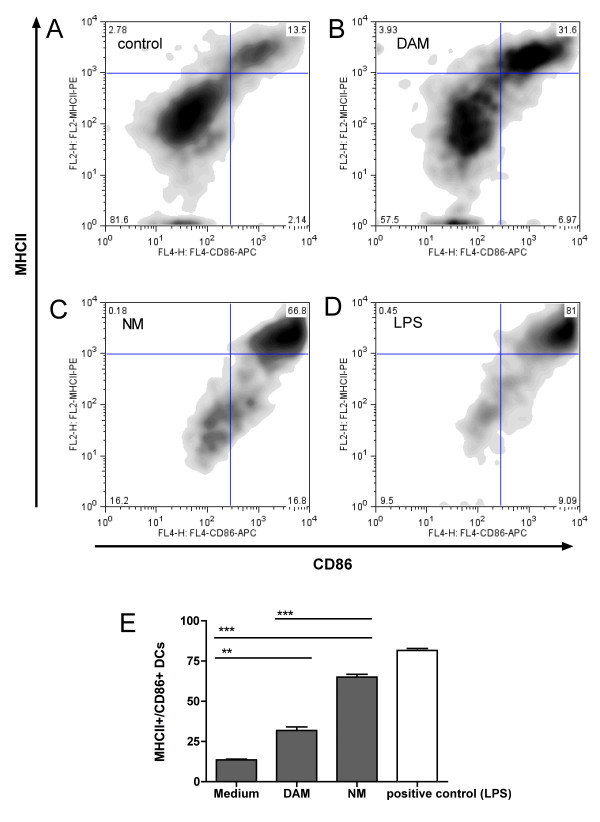
Neuromelanin triggers dendritic cell (DC) maturation. Flow cytometric analysis of DC maturation by staining with anti-CD86/anti-MHCII antibodies. A: medium-treated DCs (untreated). B: DAM-treated DCs. C: NM-treated DCs. D: positive control (LPS-treated DCs). A-D: representative experiments from triplicates. E: Illustration of the amount of mature DCs from triplicates (data as mean ± S.E.M.; statistical analysis with one-way ANOVA using Bonferroni multiple comparison as post test; n.s. = non specific (p > 0.05), * p < 0.05, ** p < 0.01, *** p < 0.001).